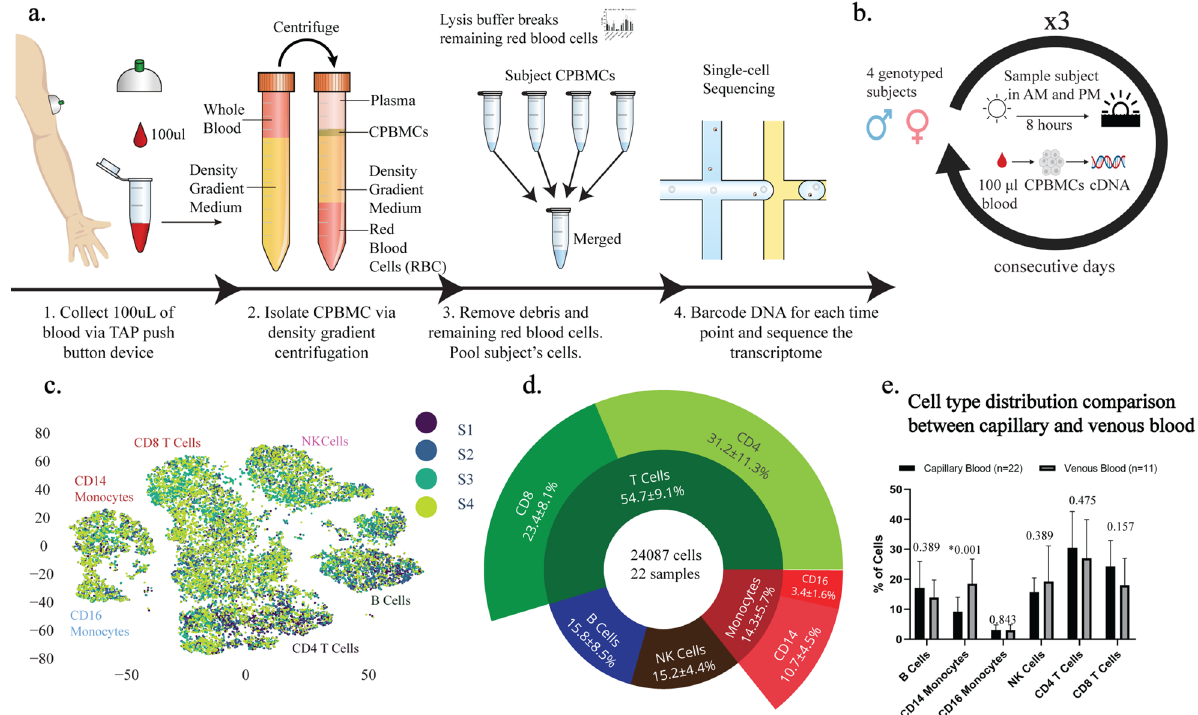
Figure 1. Experimental workflow and consistency of capillary blood sampling. ( a ) Experimental workflow for capillary blood immune profiling. 1. Blood is collected using the TAP device from the deltoid. 2. Capillary peripheral blood mononuclear cells (CPBMCs) are separated via centrifugation. 3. Red blood cells are lysed and removed, and samples from different subjects are pooled together. 4. Cell transcriptomes are sequenced using single-cell sequencing. ( b ) Time-course study design. CPBMCs are collected and profiled from 4 subjects (2 male, 2 female) each morning (AM) and afternoon (PM) for 3 consecutive days. ( c ) 2-dimensional t-SNE projection of the transcriptomes of all cells in all samples. Cells appear to cluster by major cell type (Fig. S6) ( d ) Immune cell type percentages across all samples shows stable cell type abundances (includes cells without subject labels). ( e ) Cell type ratios between capillary blood from this study, and venous blood from 3 other studies were the same, with the exception of CD14 + Monocytes, which are more abundant in venous blood (FDR < 0.05, 2-sided student t-test, multiple comparison corrected) The q-values are displayed for each cell type